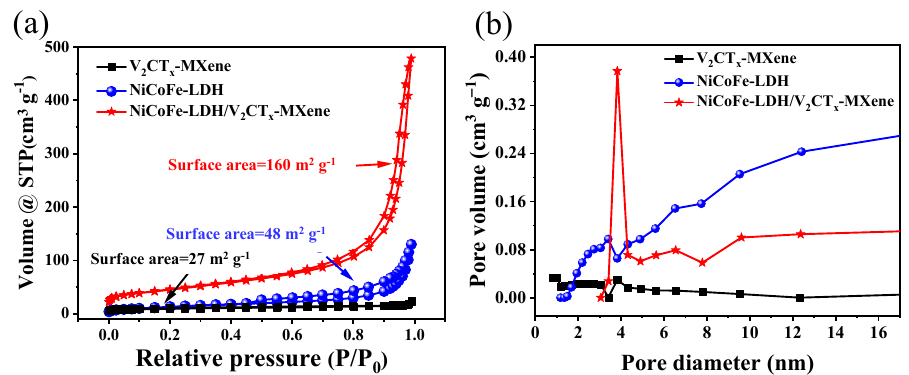
Figure 6. ( a ) N 2 adsorption–desorption isotherms. ( b ) Pore size distribution of V 2 CT x –MXene, NiCoFe–LDH, and NiCoFe–LDH/V 2 CT x –MXene.